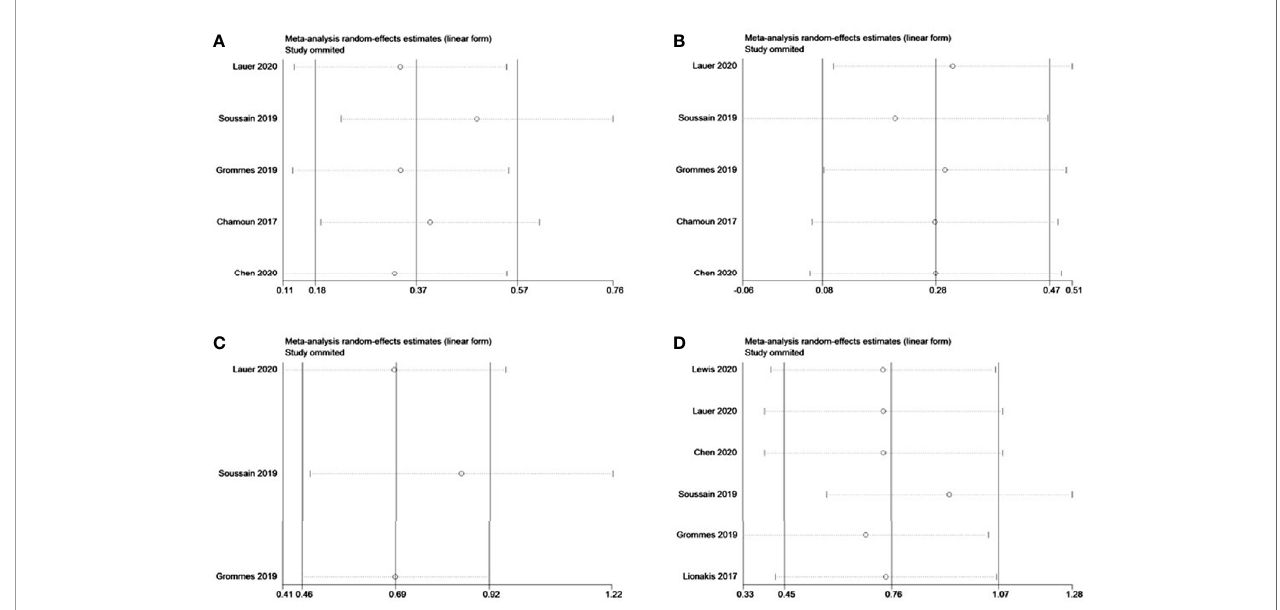
FIGURE 11 | Sensitivity analysis of refractory/relapsed central nervous system lymphoma (r/r CNSL) and MYD88 mutation. (A) Complete response of r/r CNSL. (B) Partial response of r/r CNSL. (C) 12-mouth overall survival of r/r CNSL. (D) Overall response of MYD88 mutation.